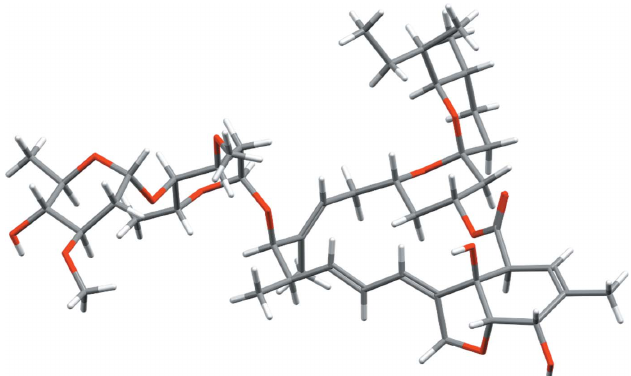
Figure 5 CSD ‘stick style’ Mercury rendering of